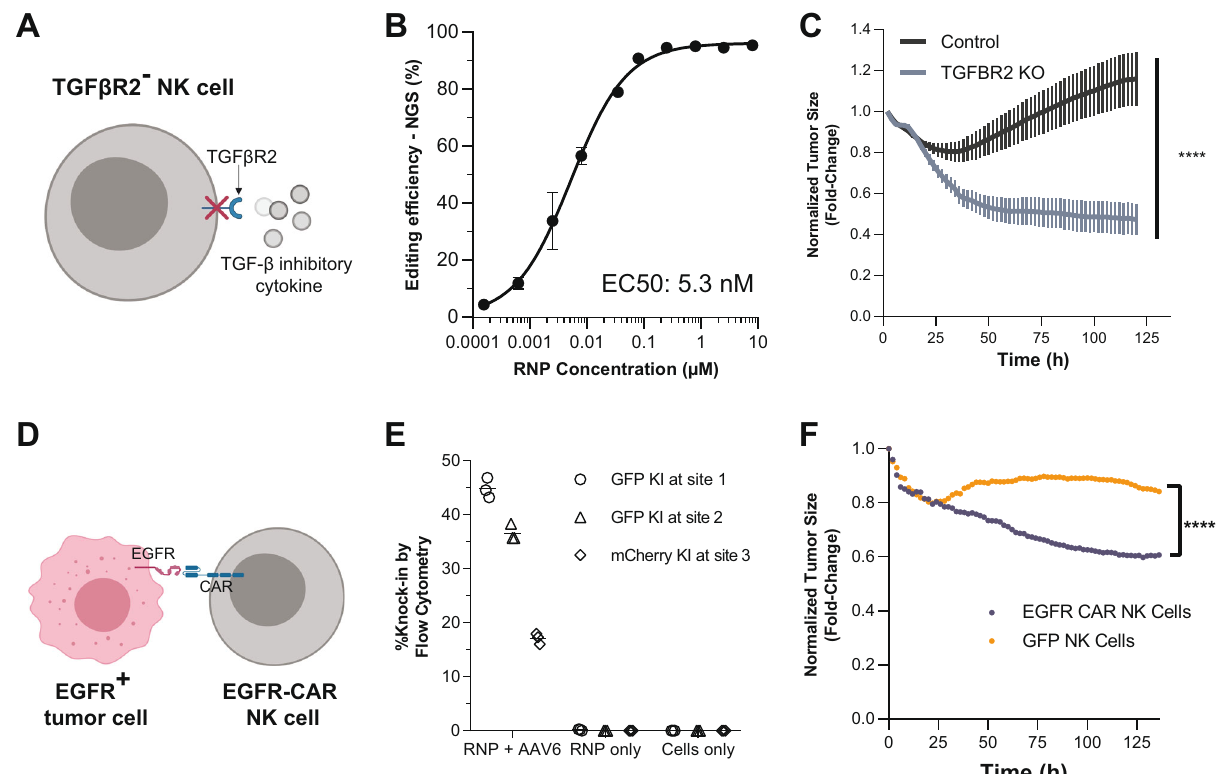
Fig. 6 AsCas12a Ultra enables ef fi cient one-step generation of allogenic CAR-NK cells. A Potential editing strategy for the generation of edited NK cells to overcome tumor microenvironment. Knocking out TGFBR2 (Transforming growth factor-beta receptor type 2) prevents inactivation by tumor-derived TGF- β 1. B Editing ef fi ciency of TGFBR2A across a range of RNP concentrations in NK cells derived from three different donors. Data are presented as mean values ± SD. C Tumor spheroid killing mediated by TGFBR2 knock-out NK cells. Engineered NK cells were co-cultured with SK-OV-3 ovarian tumor spheroids at effector-to-target cells ratio of 10:1 (E:T). The spheroid size was monitored over time by Incucyte real-time cell analysis as a proxy for